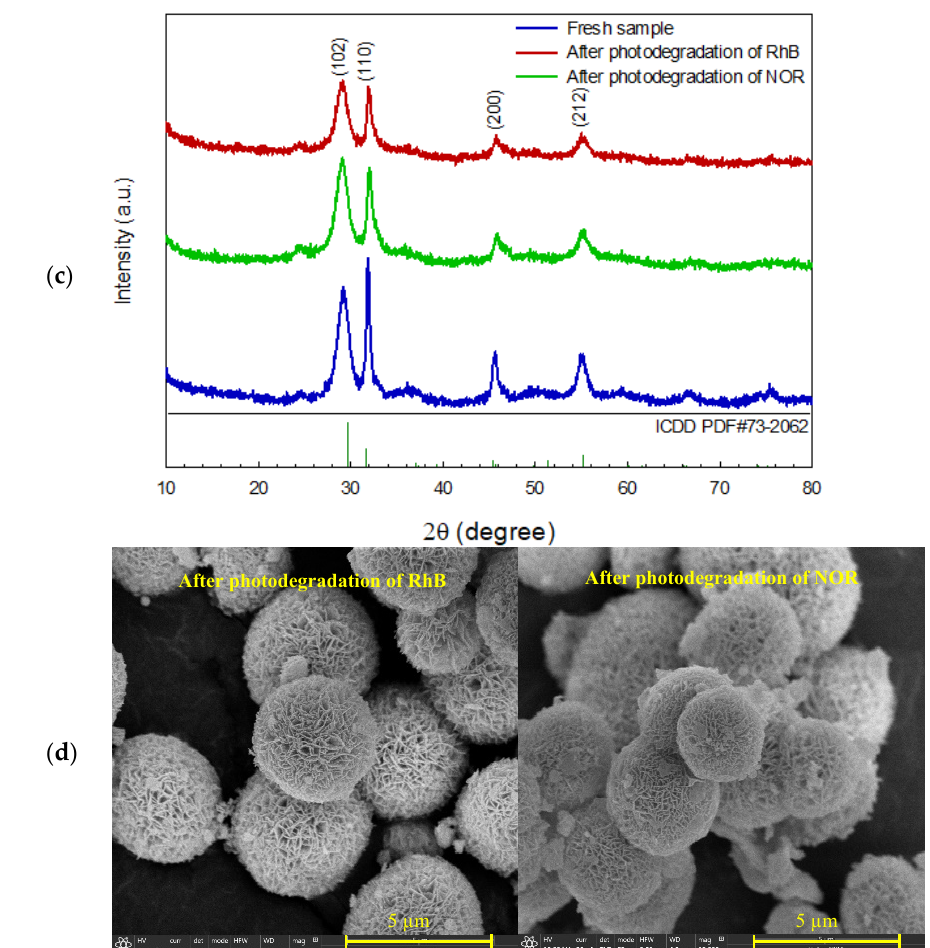
Figure 9. Reusability of the photocatalyst in the degradation of RhB dye ( a ), and NOR antibiotic ( b ), XRD patterns ( c ), and SEM micrographs ( d ) after the photodegradation of RhB dye and NOR antibiotic.